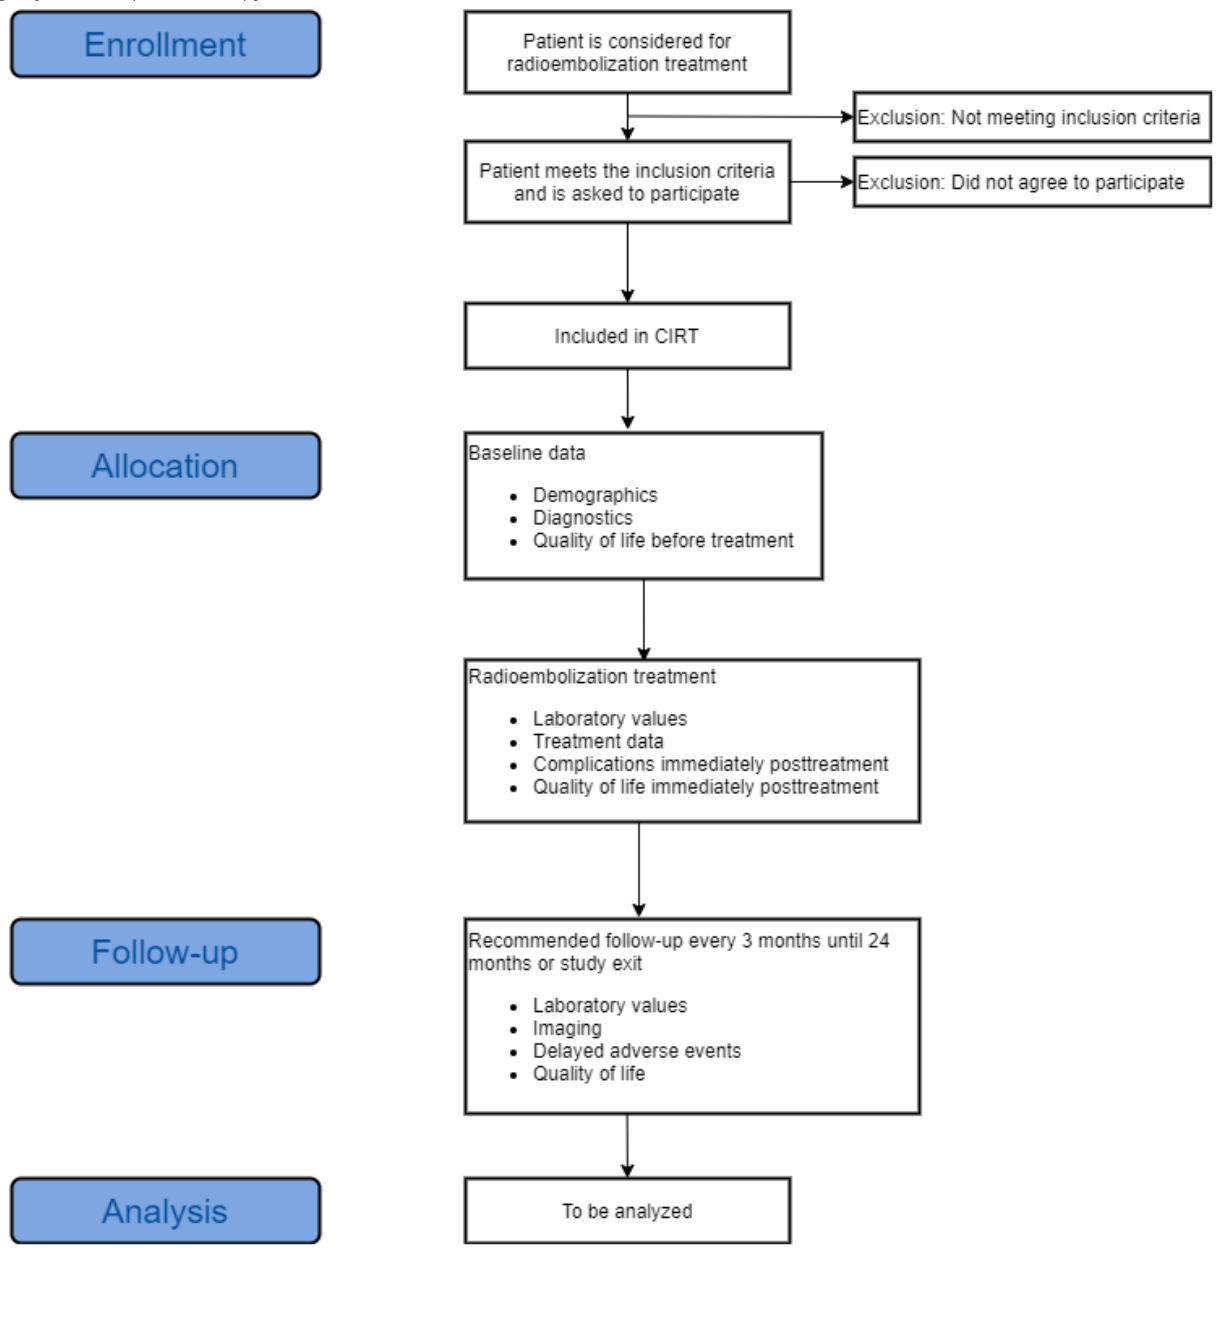
Figure 1. Flowchart of patient inclusion and measurement time points. CIRT: Cardiovascular and Interventional Radiological Society of Europe Registry for SIR-Spheres